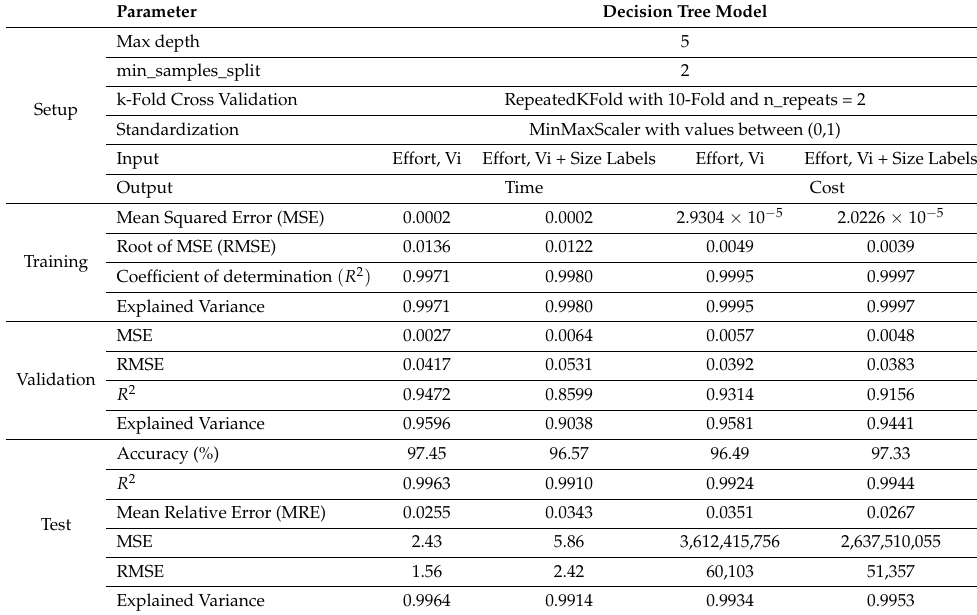
Table 8. Grouped results of DT algorithm for unlabeled and labeled data.